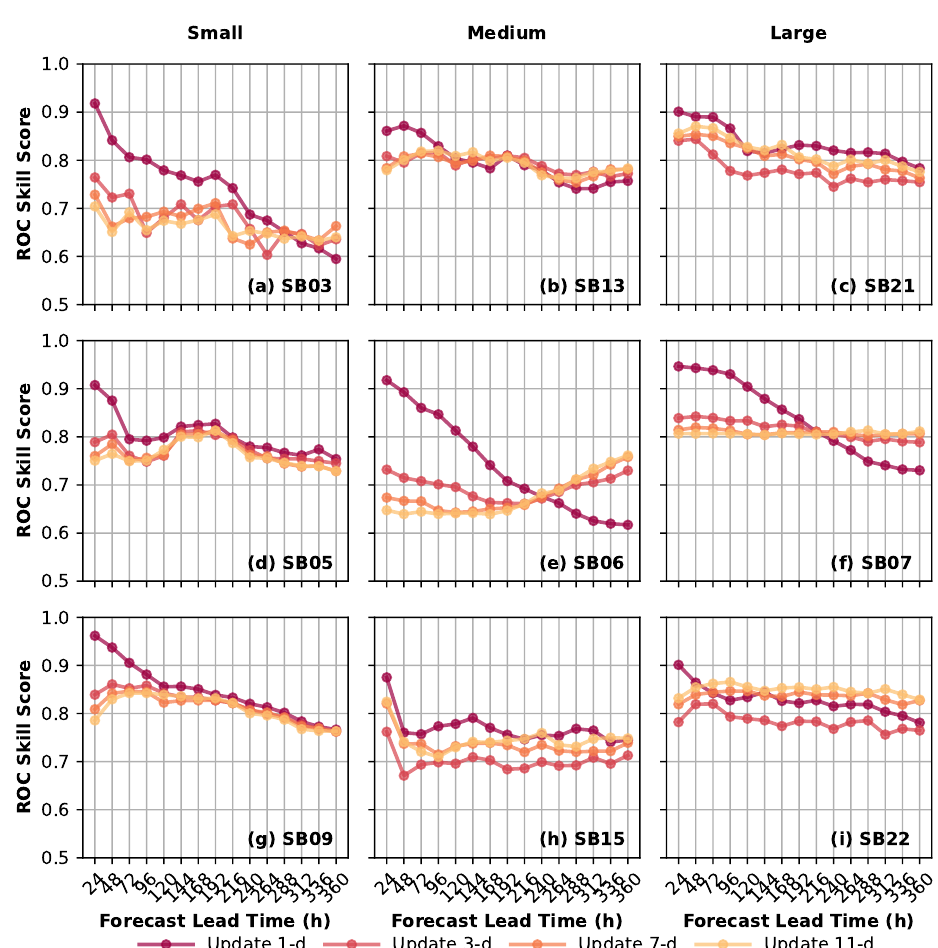
Figure 3. ROC skill score probabilistic streamflow forecast for the ECMWF ensemble model for different update frequencies and drainage areas: small sub-basins (left column), medium sub-basins (center column), and larger sub-basins (right column), for streamflow with a probability level of